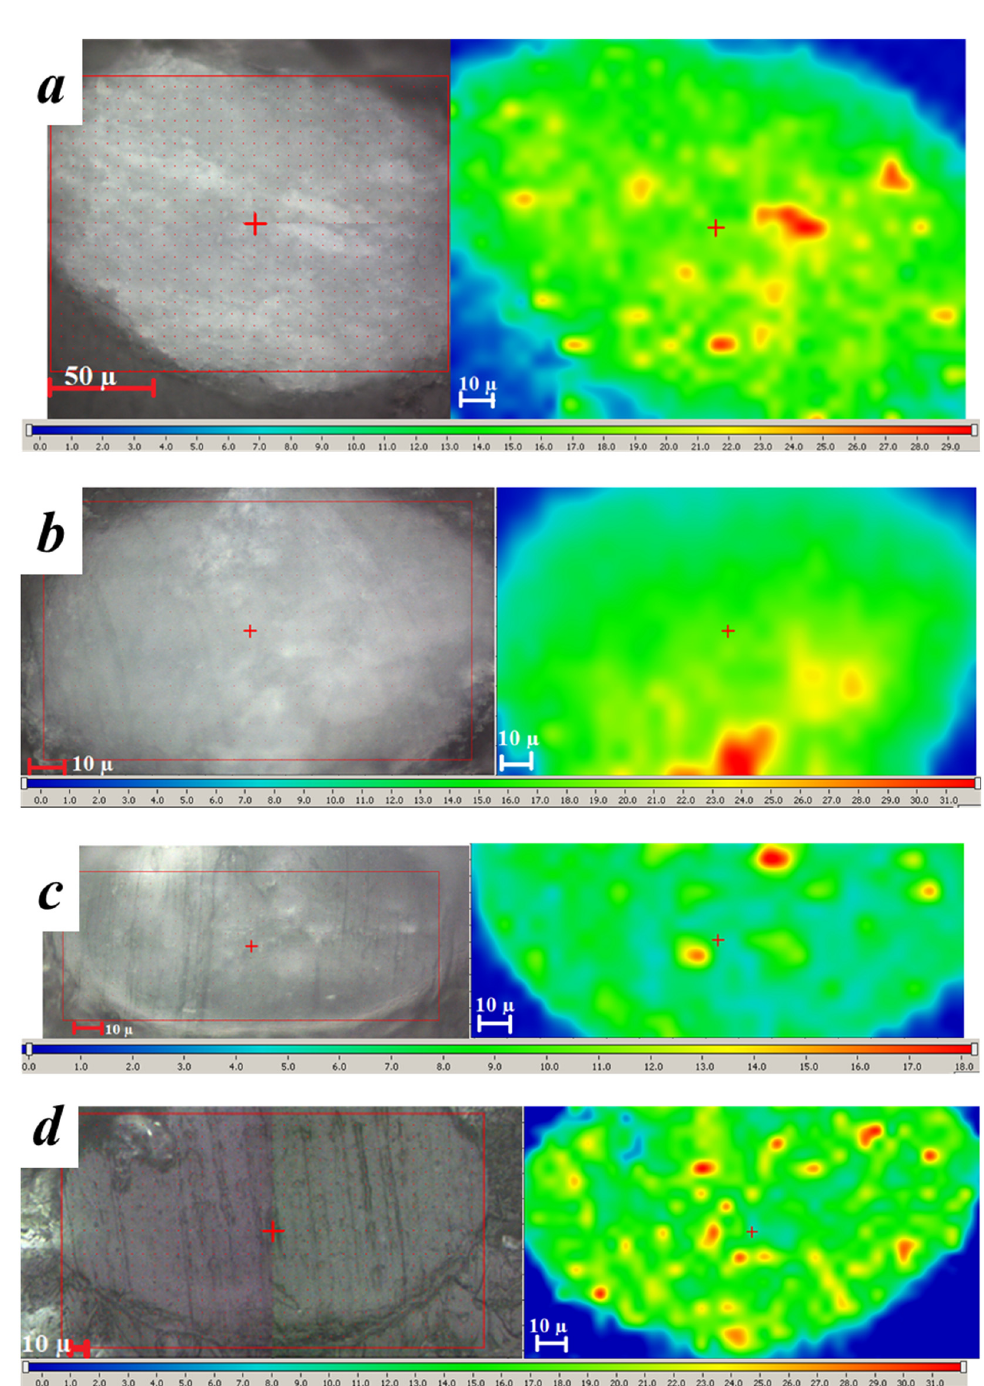
Figure 11. Images of the cross-section of the microparticles (on the left) and Raman maps of the nHA distribution within the studied microparticles (on the right). The red rectangle shows the location of the Raman map at the respective images. Microparticles based on ( a , b ) PLA or ( c , d ) PCL polymer solution containing polymer/nHA ratio as 1/1 ( a , c ) without preliminary US treatment or ( b , d ) with it.